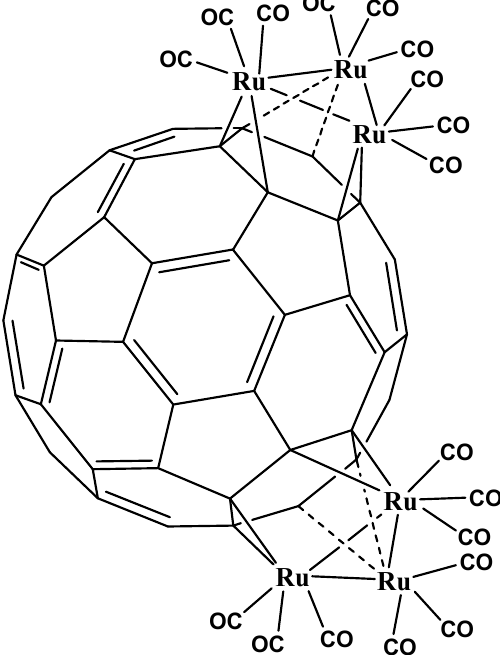
Figure 6. A complex with several η 2 substitutions in different faces